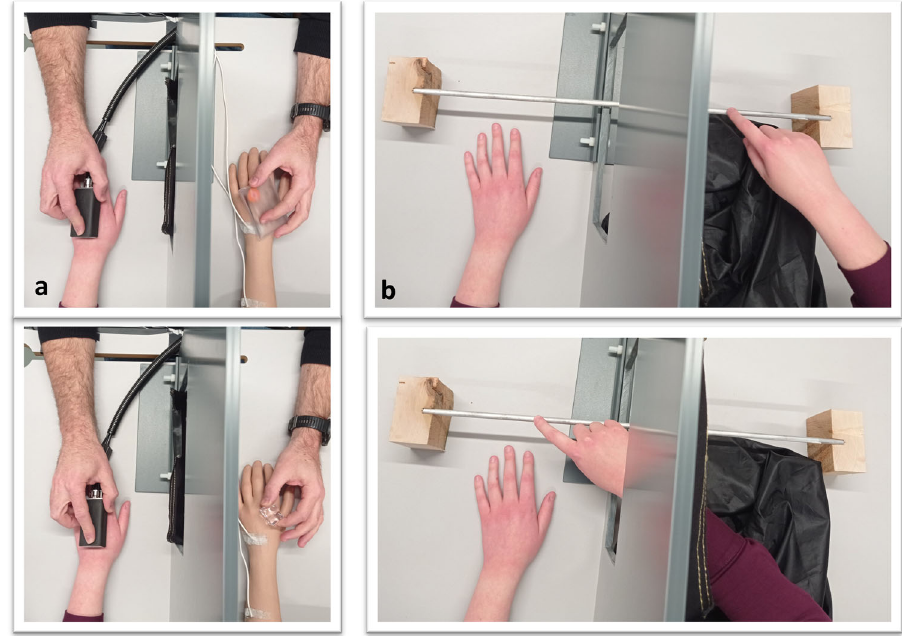
Fig. 5 Experimental setup for Experiment 1. a The thermode of the Somedic MSA Thermal Stimulator was used to deliver touch at warm (40 °C) or cold (24 °C) temperatures on the participant ’ s left hand, while participants watched the rubber hand being touched by a hand warmer (top) or an ice cube (bottom). b Visual representation of the proprioceptive drift procedure.